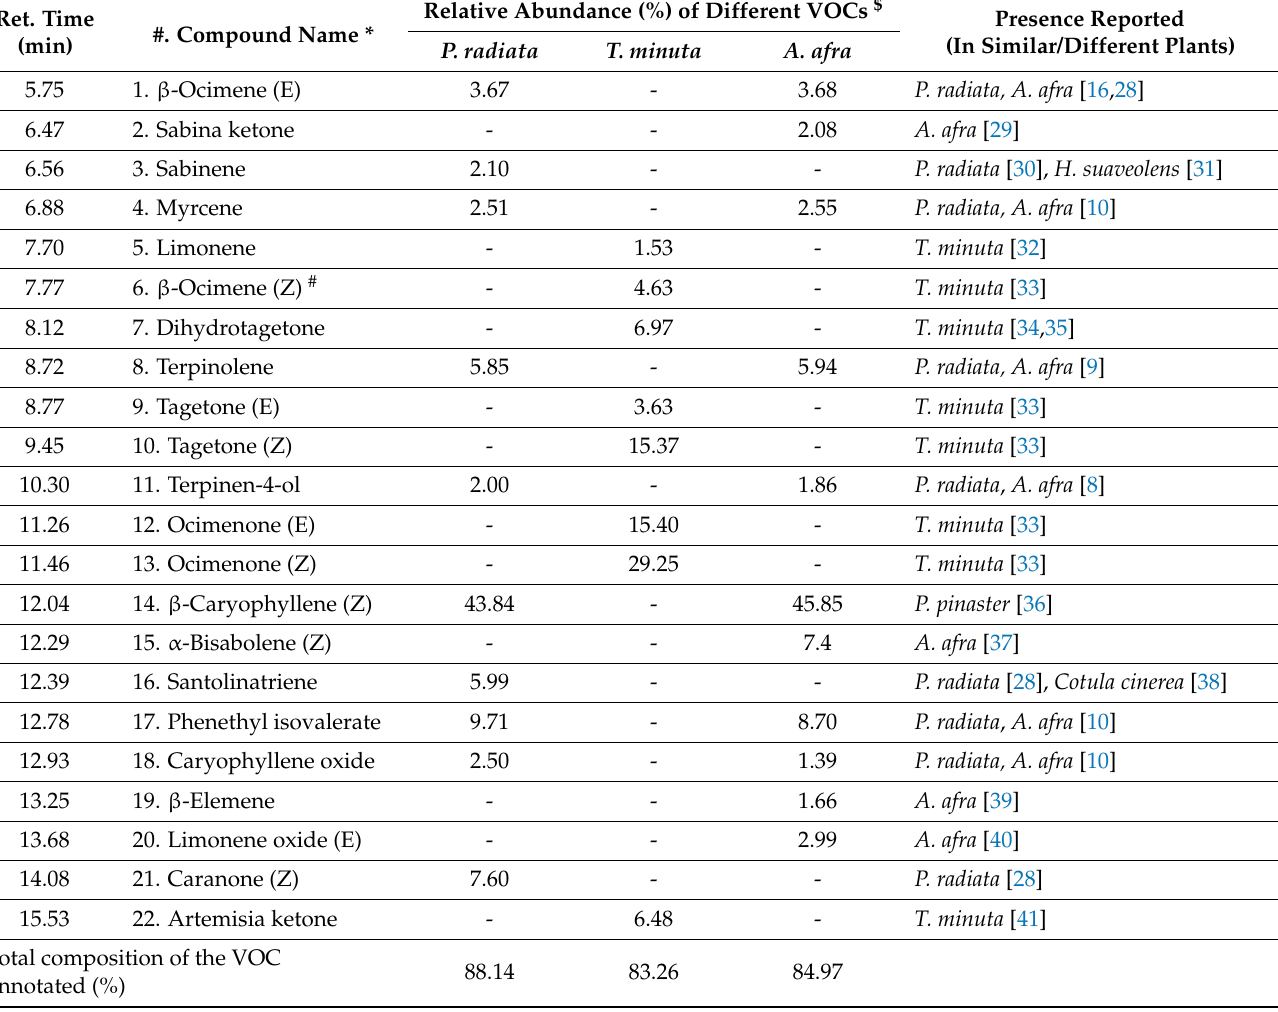
Table 1. Annotation of the most abundant volatile organic compounds obtained from different plant leaves following headspace bubble-in-drop single drop microextraction (BID–SDME) sampling and gas chromatography with mass spectrometry (GC–MS) detection. Structures of the compounds are shown in Table